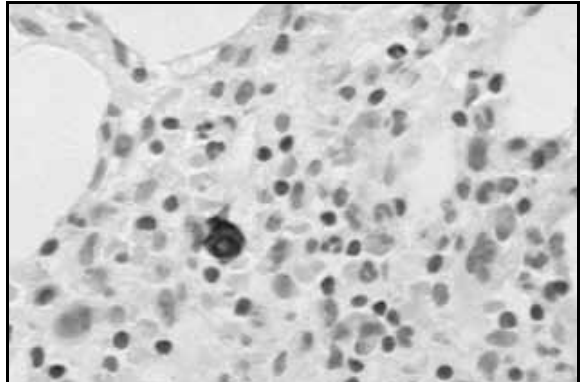
Figura 4 – Biópsia de medula óssea exibindo eritroblasto com imunopositividade com o anticorpo antiparvovírus (IHQ, 40×) IHQ: imuno-histoquímica eritema infeccioso, ou quinta doença, cursando com febre baixa e rash cutâneo (10)